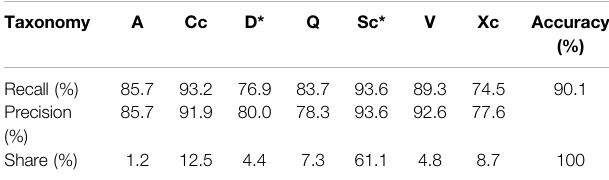
TABLE 3 | The accuracy of the neural network classi fi er per taxonomic type with simpli fi ed taxonomy. The “ Cc ” stands for the C-complex, now also including the B-type. “ D* ” is the D-type and the T-type. “ Sc* ” is the S-complex with the K and L-types. “ Xc ” is the